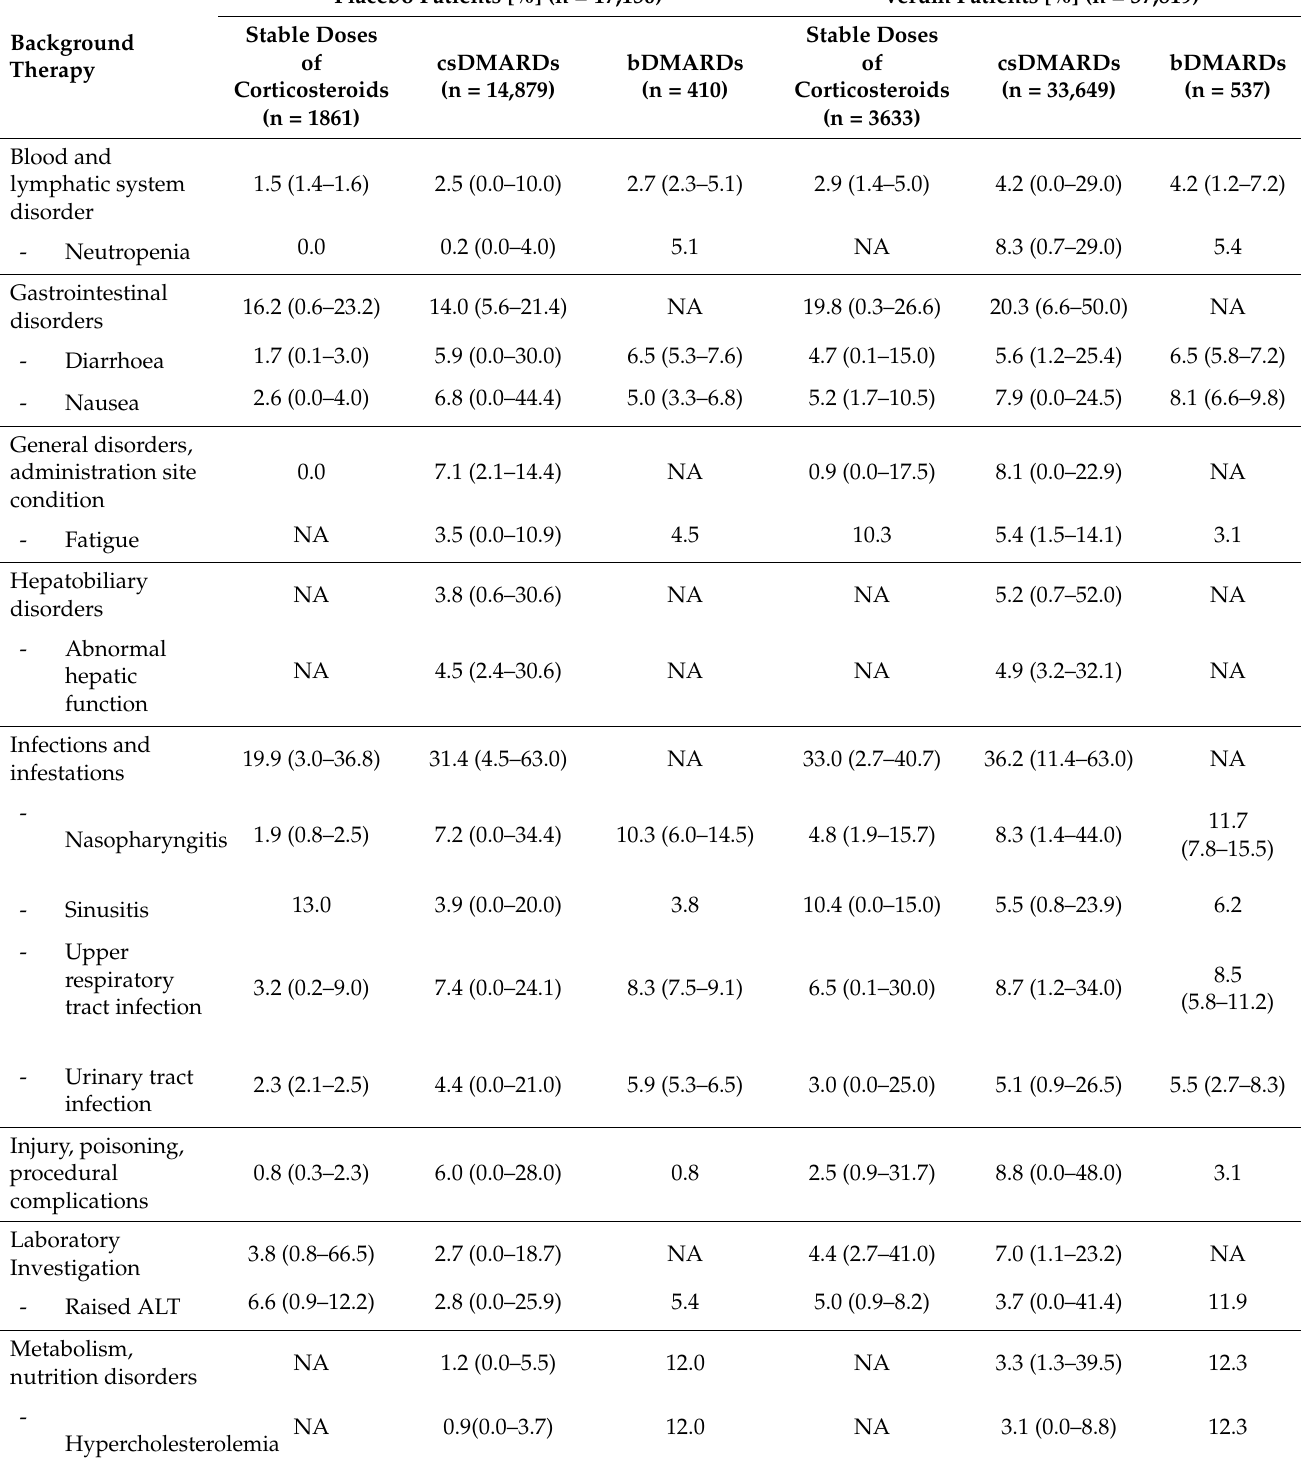
Table 3. MedDRA list of adverse events in percentages of placebo patients compared to the verum- treated patients depending on the background therapy (in alphabetical order, data are listed only with adverse events occurring more frequently than in 5% of the patients, at least in one group, and ranges are given only in groups with data available from more than one